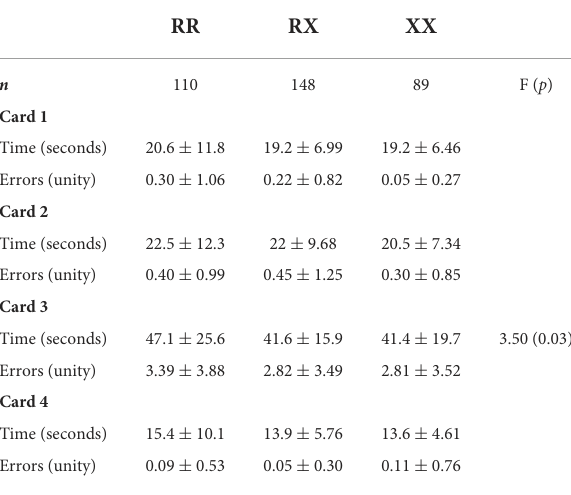
TABLE 5 Stroop test